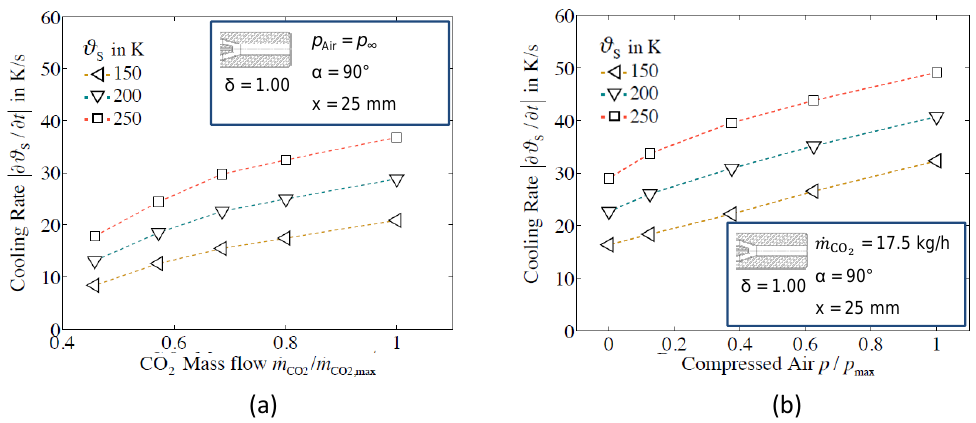
Figure 4. Influence of the supplied CO 2 mass flow ( a ) and the compressed air ( b ) on the cooling rate.